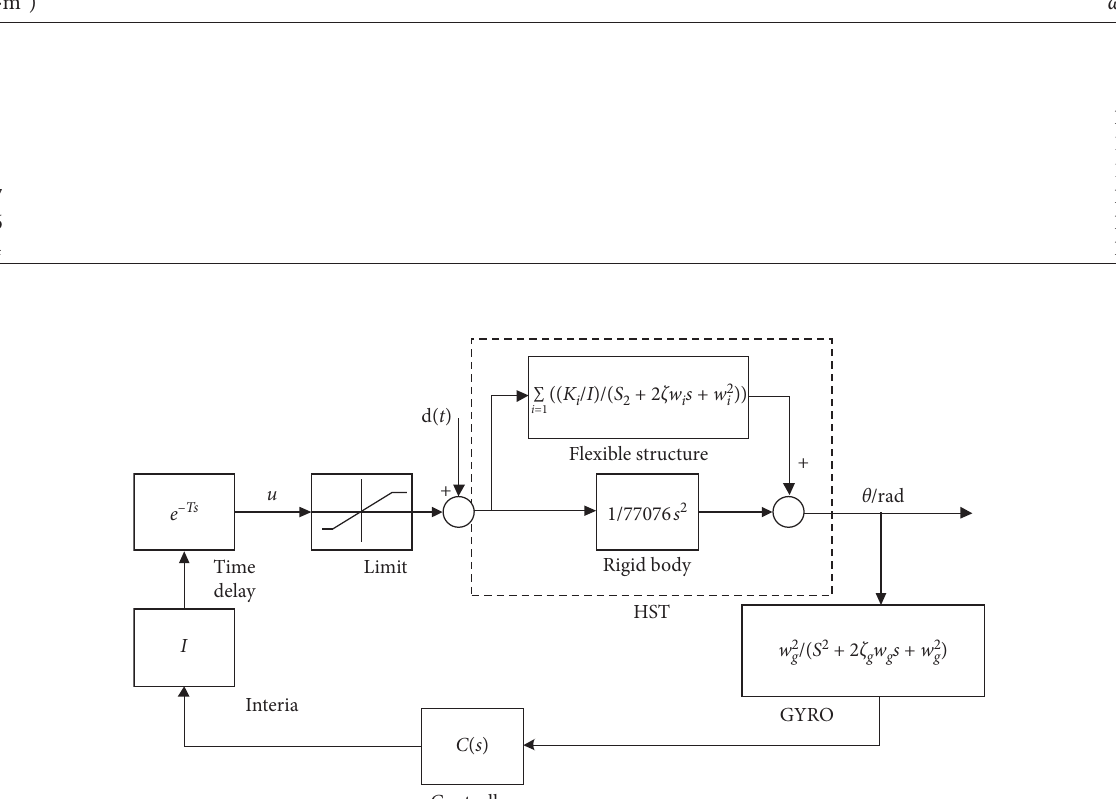
Figure 2: Block diagram of the Hubble Space Telescope control